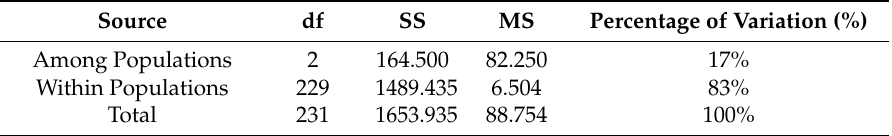
Table 6. Results of the analysis of molecular variance (AMOVA) for three populations of T . koraiensis . Source df SS MS Percentage of Variation (%) Among Populations